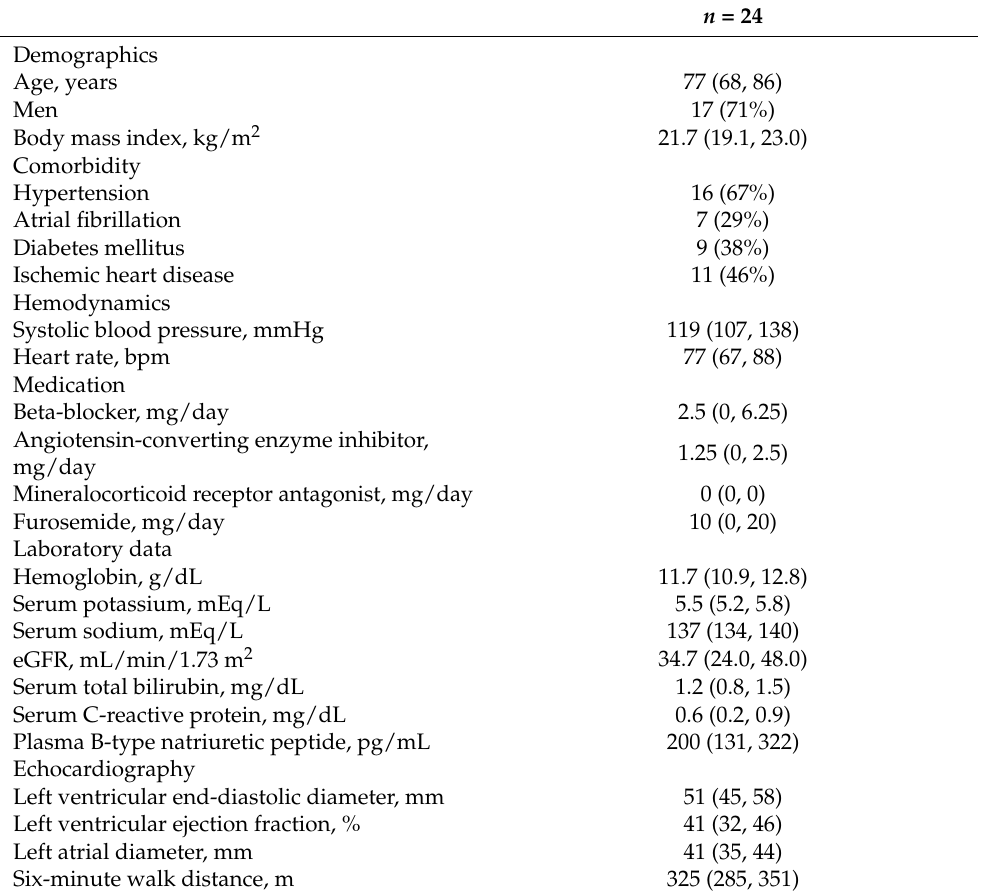
Table 1. Baseline